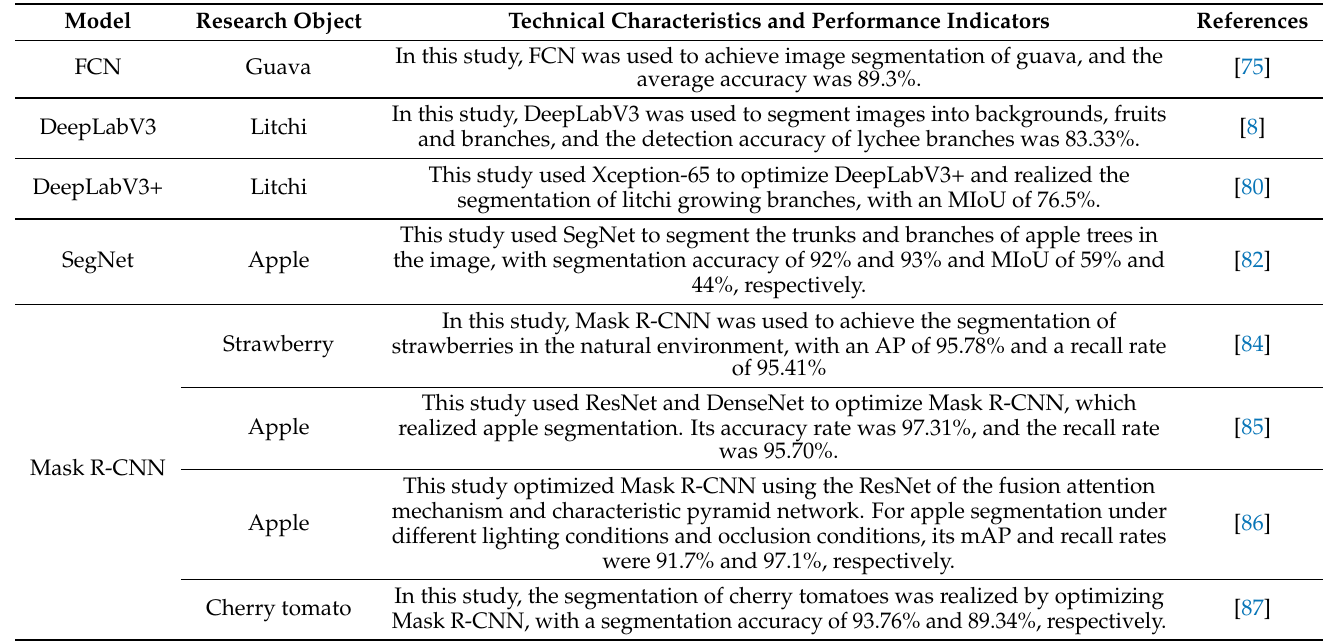
Table 3. Comparison of research results of deep-learning-based target segmentation methods.